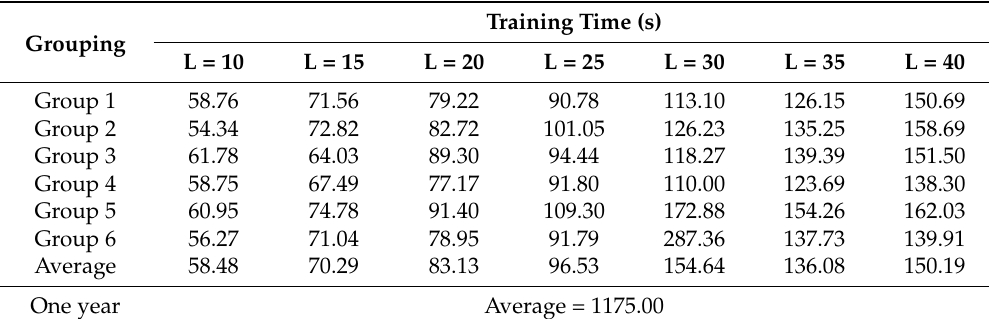
Table 3. Training time of models with different time